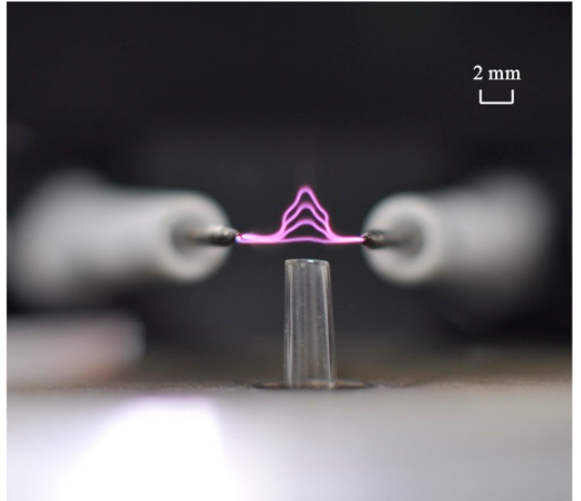
Figure 11. Filamentary anemometry using femtosecond laser-extended electric discharge (FALED) photo taken by the single lens reflex (SLR) camera of four sequential discharges with a separation of 40 μ s and a gas flow speed of 35 m/s.